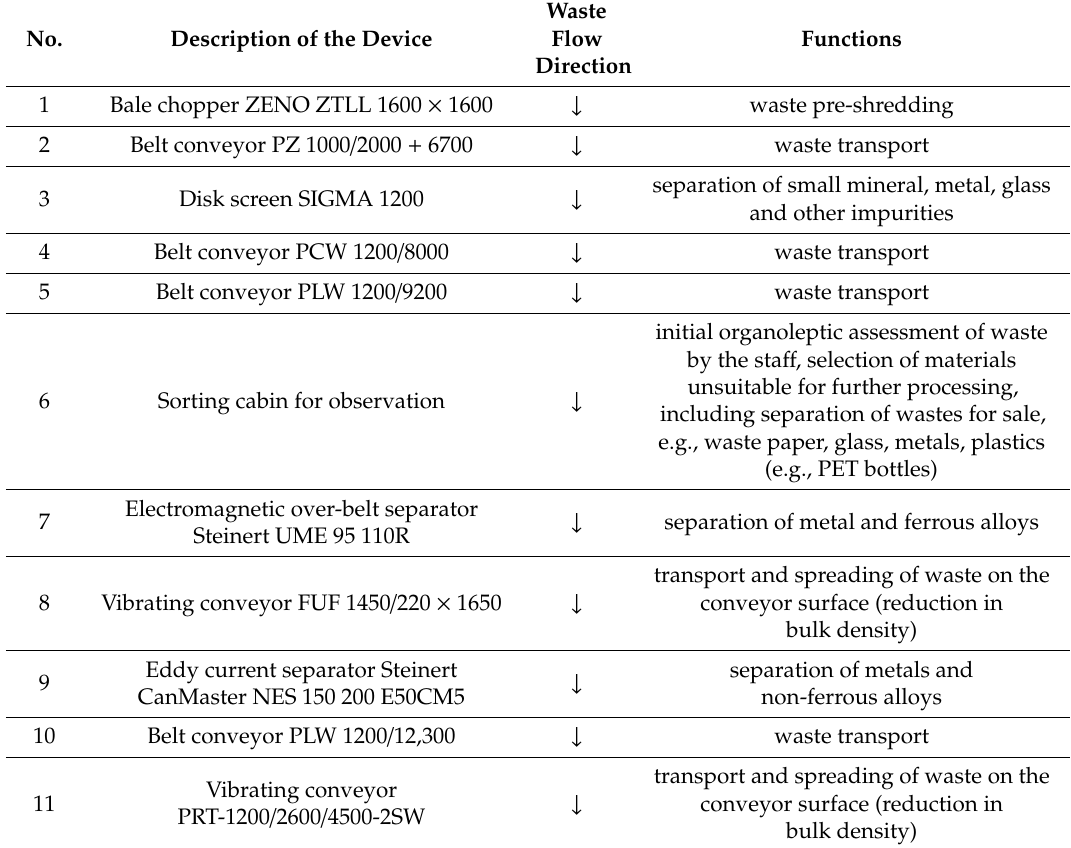
Table 2. The devices according to the direction of the sorting process.